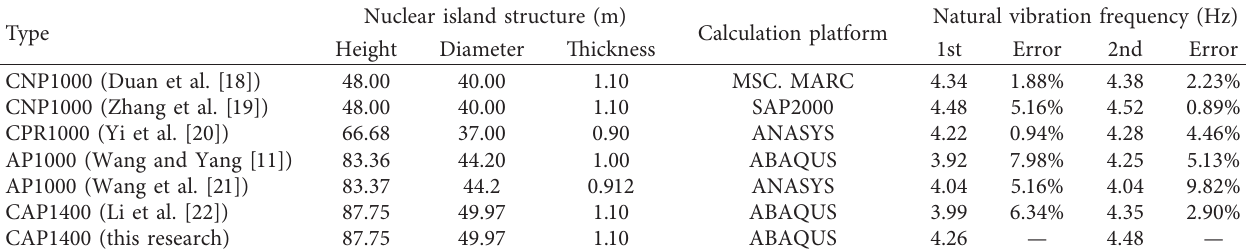
Table 2: Comparison of the first two order modes of the nuclear island structure model.